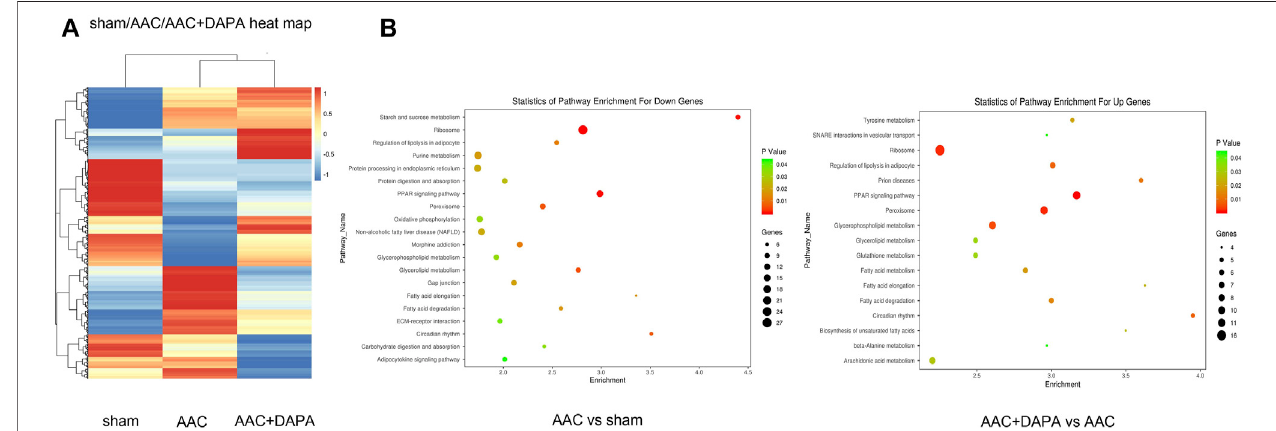
FIGURE 4 | Differential gene analysis of dapagli fl ozin in AAC-induced mice detected by gene microarray (A) Clustered heat map showed the differential gene expression pro fi le after dapagli fl ozin treatment in AAC-induced mice. (B) Signaling pathway enrichment analysis among different groups, the PPAR signal pathway (red line) is the signal pathway of this